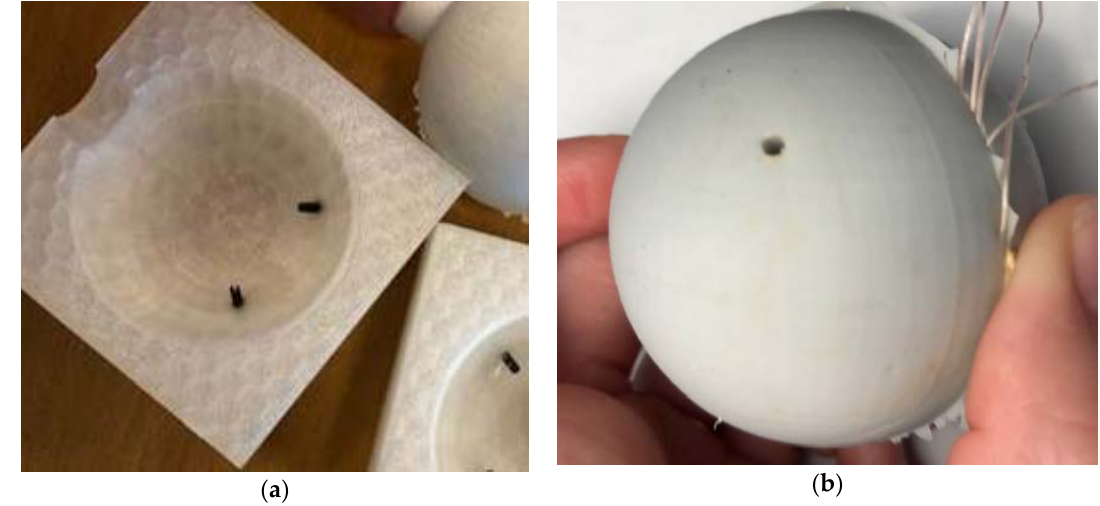
Figure 3. 3D printed mold and resulting rubber sphere molded concentrically over a steel sphere: ( a ) 3D printed rubber mold; ( b ) Demolded rubber assembly.